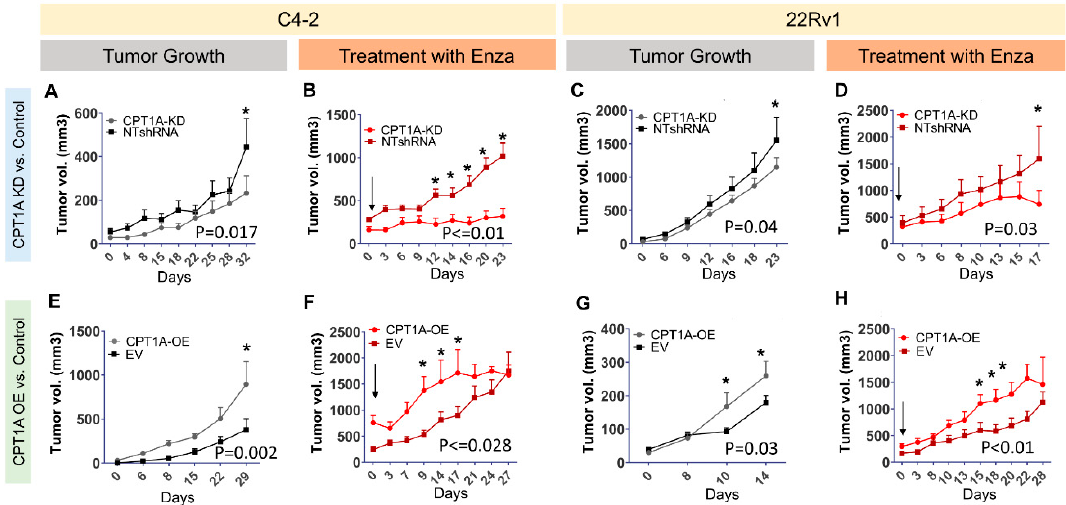
Figure 5. CPT1A expression in tumors modulates their growth and the response to enzalutamide in castrated mice. NSG mice were used for the C4-2 cells and nu/nu mice for 22Rv1 cells. Mice were castrated 2 weeks before cell implantations. Figures ( A ) and ( C ) show tumor growth curves for C4-2 and 22Rv1 with CPT1A -KD and control NT-shRNA cells, respectively. Similarly, Figures ( E ) and ( G ) show tumor growth curves for C4-2 and 22Rv1 with CPT1A -OE and EV control cells, respectively. In separate experiments, mice received oral gavage of 20 mg/kg enzalutamide (Enza) once tumors were established and growing ( ≥ 300 cc). Figures ( B ) and ( D ) show response to Enza in tumors with CPT1A -KD, whereas figures ( F ) and ( H ) show response to Enza in tumors overexpressing CPT1A ( OE ). Significance differences are indicated (*) for each group. Mouse numbers per graph: ( A ): (NT = 11, KD = 13), ( B ): (NT = 5, KD = 5), ( C ): (NT = 12, KD = 14), ( D ): (NT = 5, KD = 5), ( E ): (EV = 8, OE = 8), ( F ): (EV